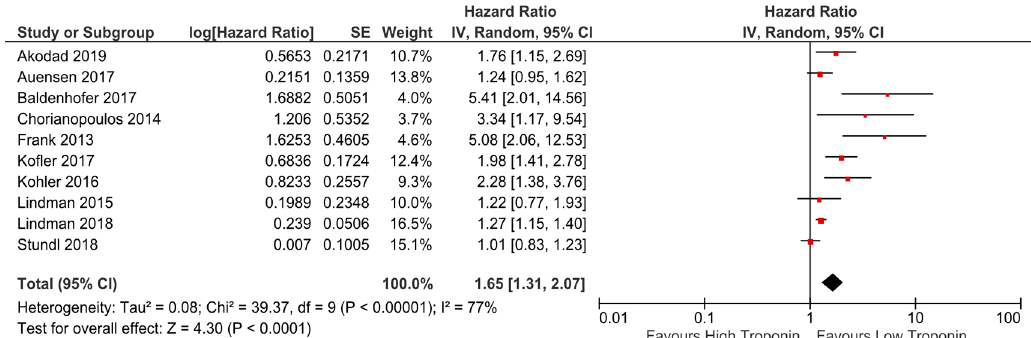
Figure 2. Forest plot of hazard and risk ratios of all-cause mortality for high vs. low levels of baseline Troponin using a random-effect model. This indicates that when comparing groups of high vs. low Troponin there was 1.65 times the risk of mortality in the higher group. CI: confidence interval; IV: inverse variance.